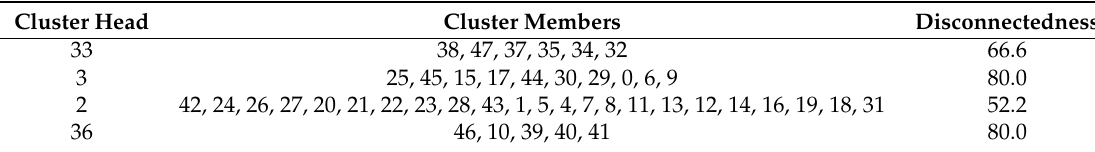
Table 2. Average disconnectedness: UAKM